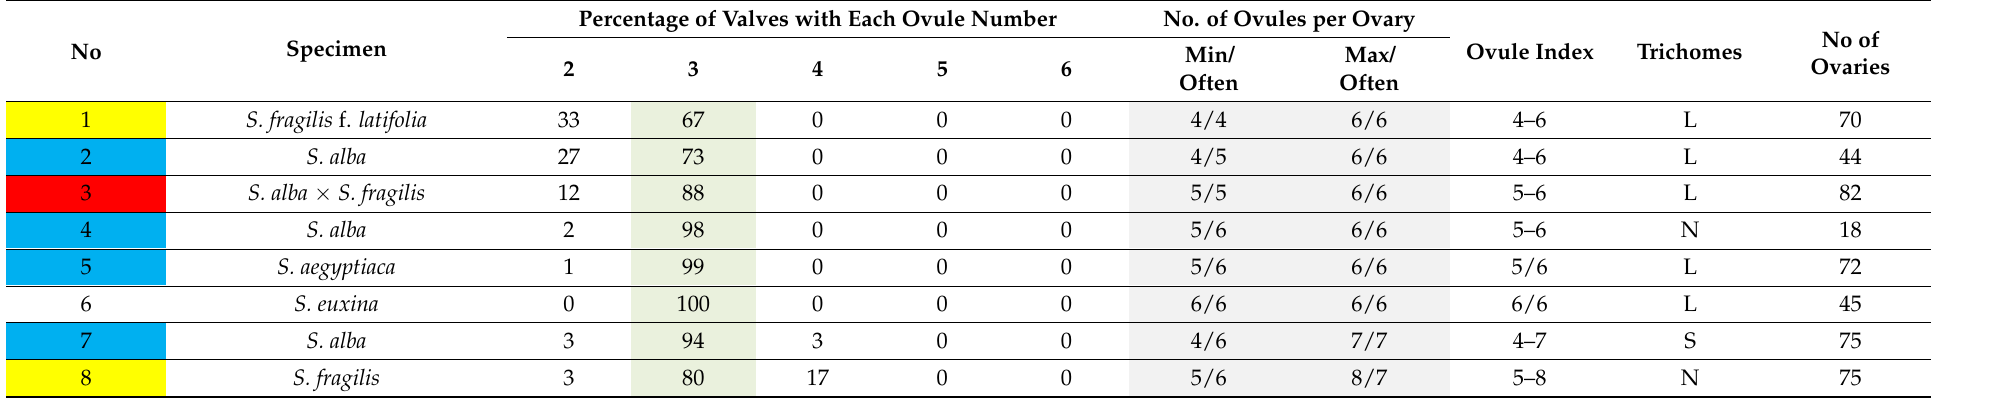
Table 2. The ovule data for Salix alba , S. fragilis and S. alba × S. fragilis with 1 to 6 ovule/valve. Each capsule in Salix has 2 valves and the presented data include the percentage of valves in a catkin with different numbers of ovules. The additional characteristics are included: the number of ovules per ovary (min/often and max/often), the ovule indices (the minimum and maximum number of ovules per ovary), presence of trichomes at bract apex (A—bracts abscised; L—long; N—none; S—short), and number of studied ovaries. The entries with the specimens’ numbers (column 1) were colored according to their names based on